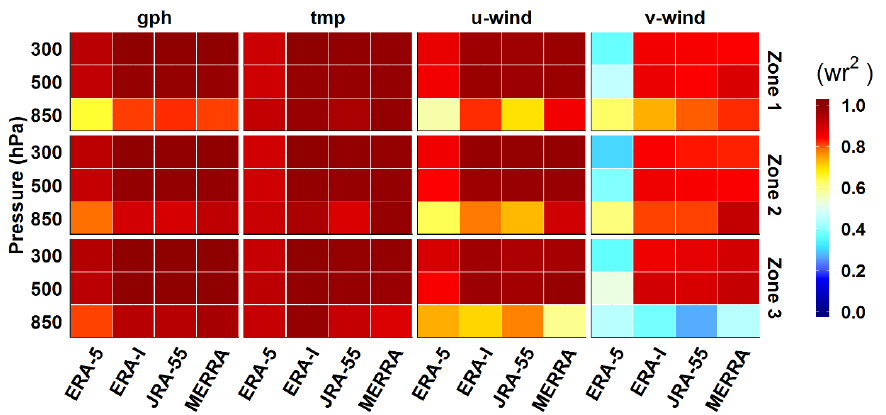
Figure 4. Weighted coefficients ( 𝜔 r 2 ) of the vertical profiles of gph (m), tmp (°C), and horizontal wind (m/s) at annual scale.